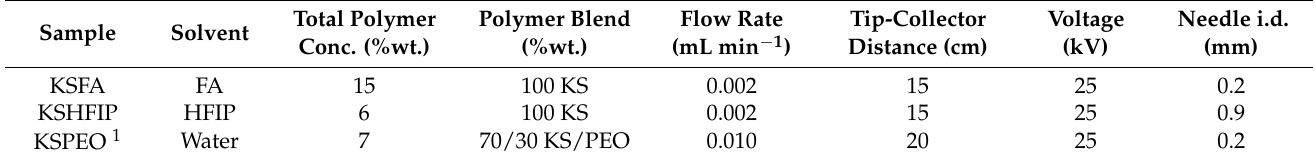
Table 1. Electrospinning conditions–all samples were electrospun for 1 h at 22 ◦ C and 28% RH. Total Sample Solvent